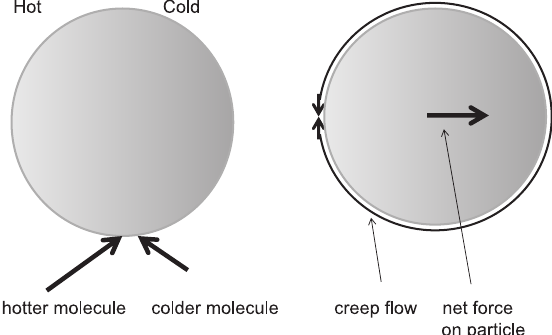
Fig. 4 Photophoretic force on a particle in the continuum regime. The particle is hotter on the left side and in the immediate vicinity of the surface, the gas molecules have the same temperature as the surface. Molecules impacting on the particle from the left are faster than those coming from the right, transferring a momentum to the right onto the particle. This momentum is lost in the gas, thus a thermal creep flow of the gas molecules to the left